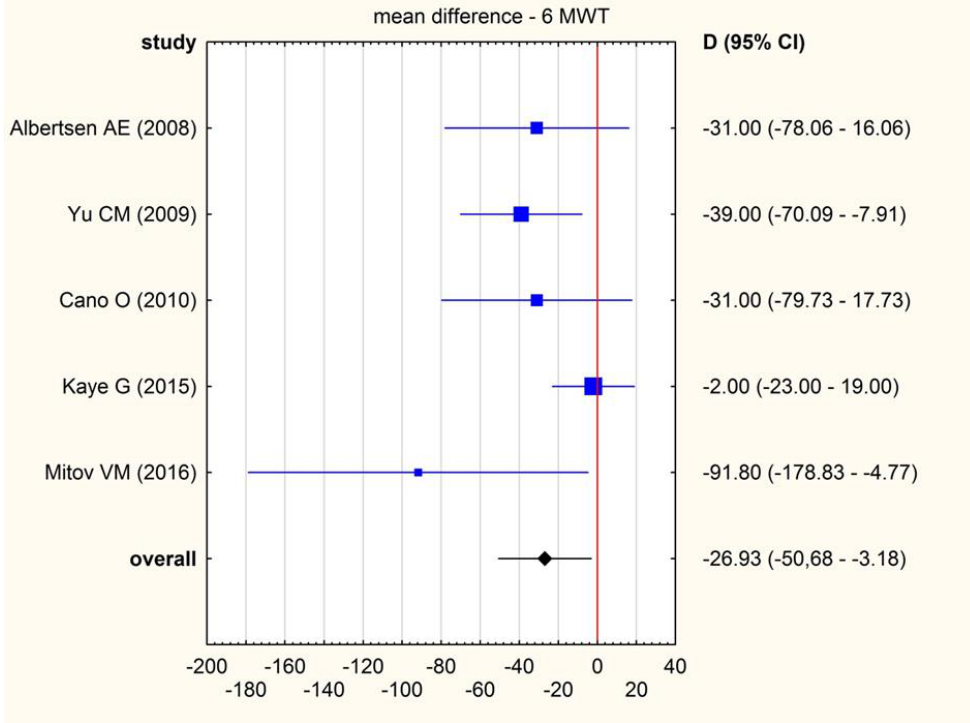
Figure 4. Forrest plot illustrating pooled mean difference (MD) with a 95% confidence interval (CI) of 6MWT (meters)